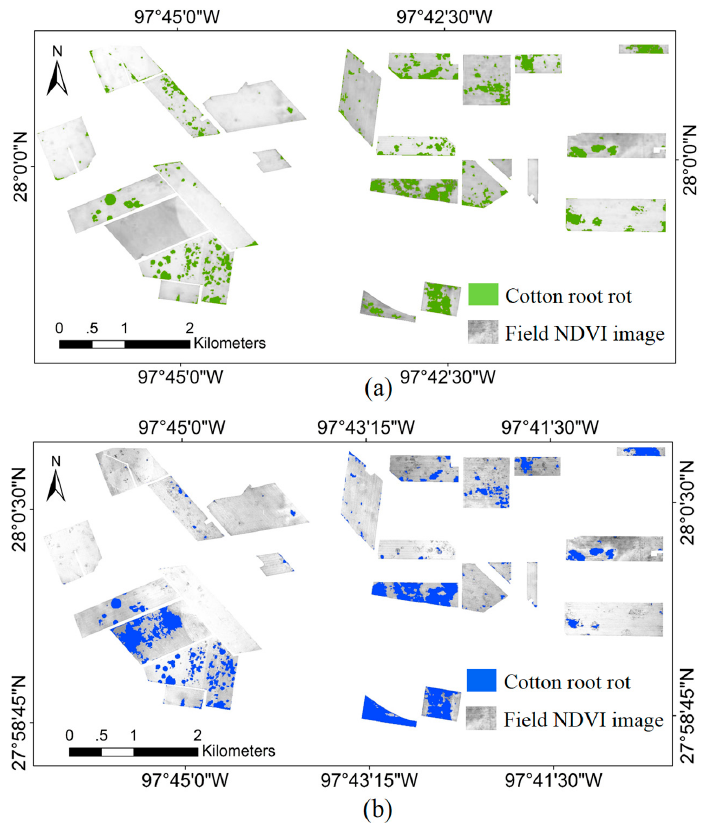
Figure 6. Classification maps generated from Sentinel-2A image. ( a ) Map generated from field subset Sentinel-2A images; ( b ) map generated from whole sentinel-2A image for the study area. Table 2. Estimates of cotton root rot-infested areas based on the classification map generated by field subset Sentinel-2A images for 24 cotton fields.